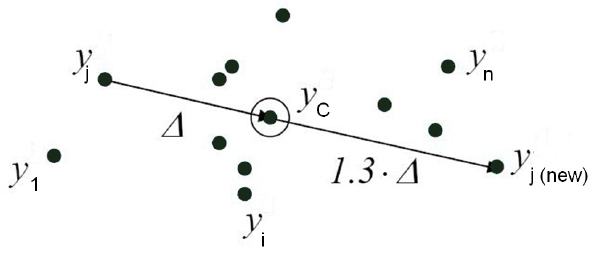
Figure 29: Complex search method. The worst design y j is mirrored through centroid y c